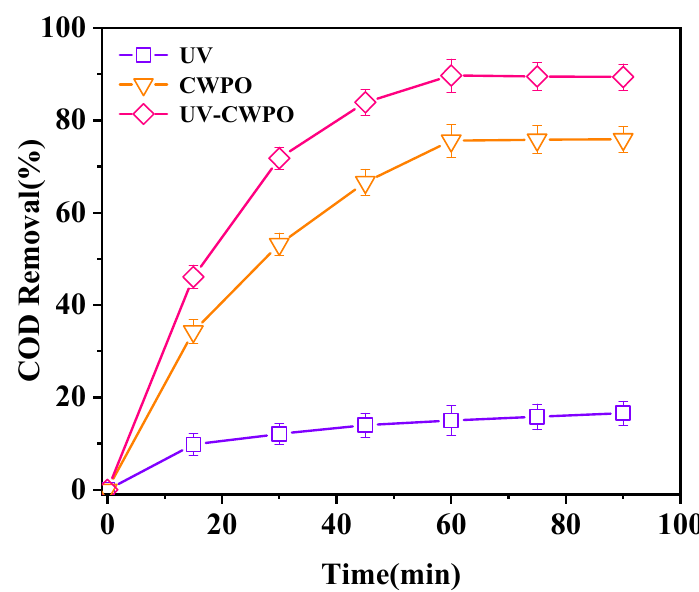
Figure 10. Comparison to different reaction systems. (Reaction conditions: LaCoO 3 /CeO 2 = 1 g/L, H 2 O 2 = 40 mM, 120 °C, 0.5 MPa).